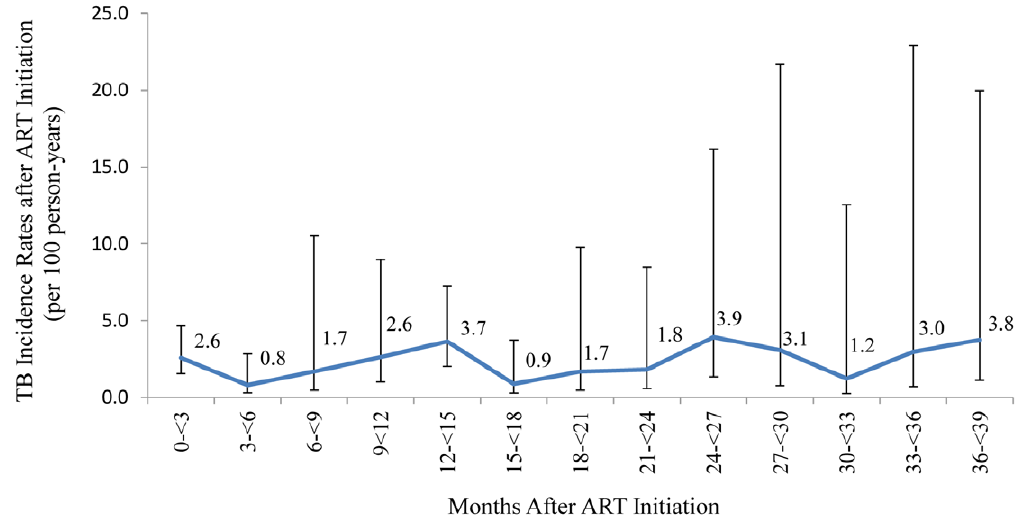
Figure 3. TB Incidence Rates during ART Follow-up among Patients Assessed as TB-free at ART Initiation (n=2,325).